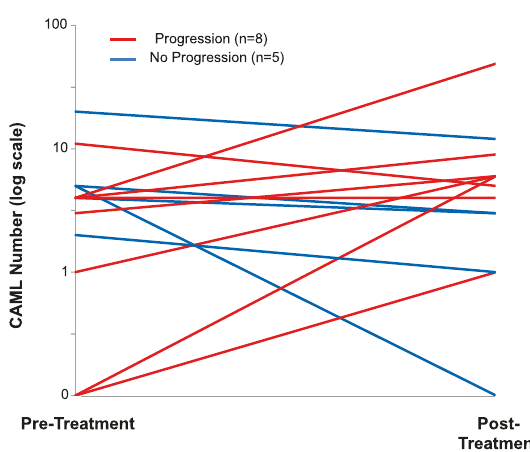
Fig. 5 CAML enumeration for patients that progressed within 2 years versus patients that did not progress. Patients who volunteered for multiple blood draws during the course of treatment ( n = 13). Pre-Treatment and post-treatment time points were taken. Patients that experienced progression during a 2 year period (red lines), with six patients having an increase in CAML number, one patient having equal numbers, and one having a decrease in CAML number from 11 to 5 CAMLs. Patients that did not experience progression during a 2 year period (blue lines), with all fi ve non-progressing patients had a decrease in CAML